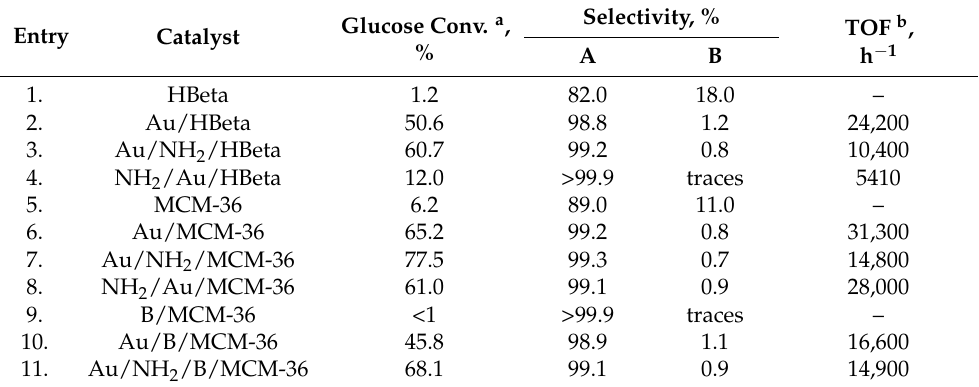
Table 3. Results of base-free oxidation of glucose with molecular oxygen over selected